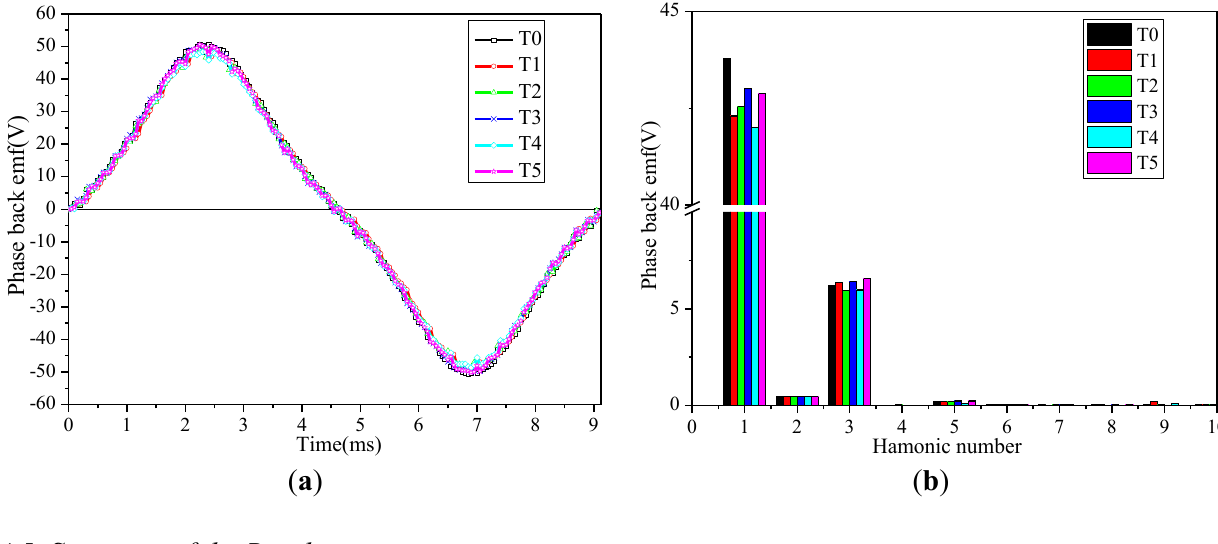
Figure 18. Back electromotive force (EMF): ( a ) profiles in one electrical cycle; and ( b )